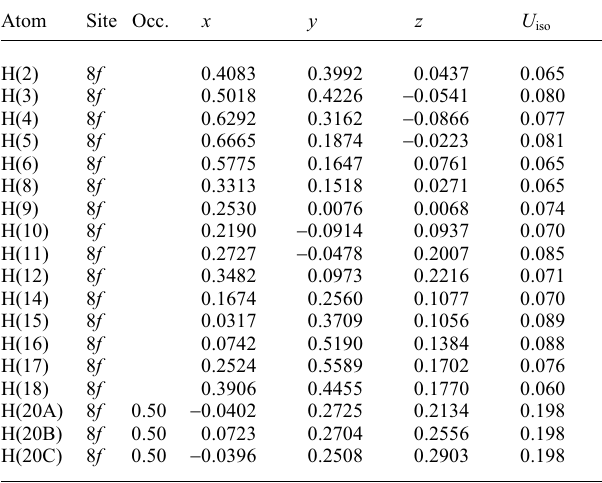
Table 2. Atomic coordinates and displacement parameters (in Å 2 )